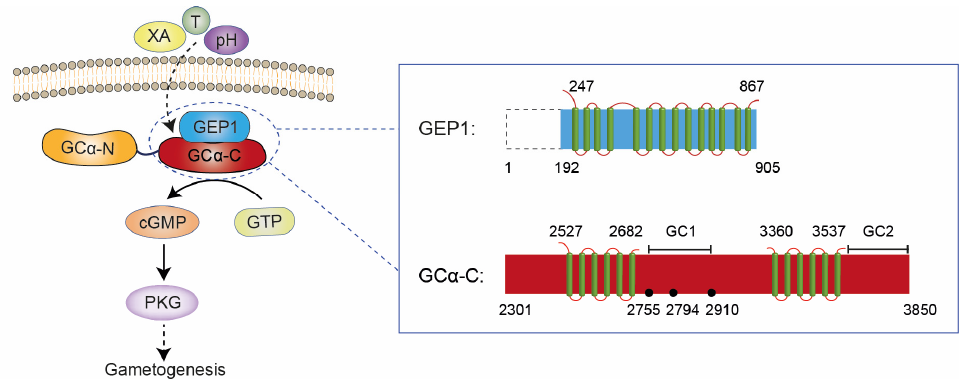
Figure 6. A working model of GEP1/GC α -dependent cGMP signaling pathway essential for game- togenesis. Domain organization and mutation sites are shown on the right. XA: xanthurenic acid; T: temperature; cGMP: cyclic guanosine monophosphate; GTP: guanosine triphosphate; PKG: protein kinase G; GC1: guanylate cyclase 1 domain; GC2: guanylate cyclase 2 domain. Green bars indicate TMHs and black dots indicate the mutation sites.